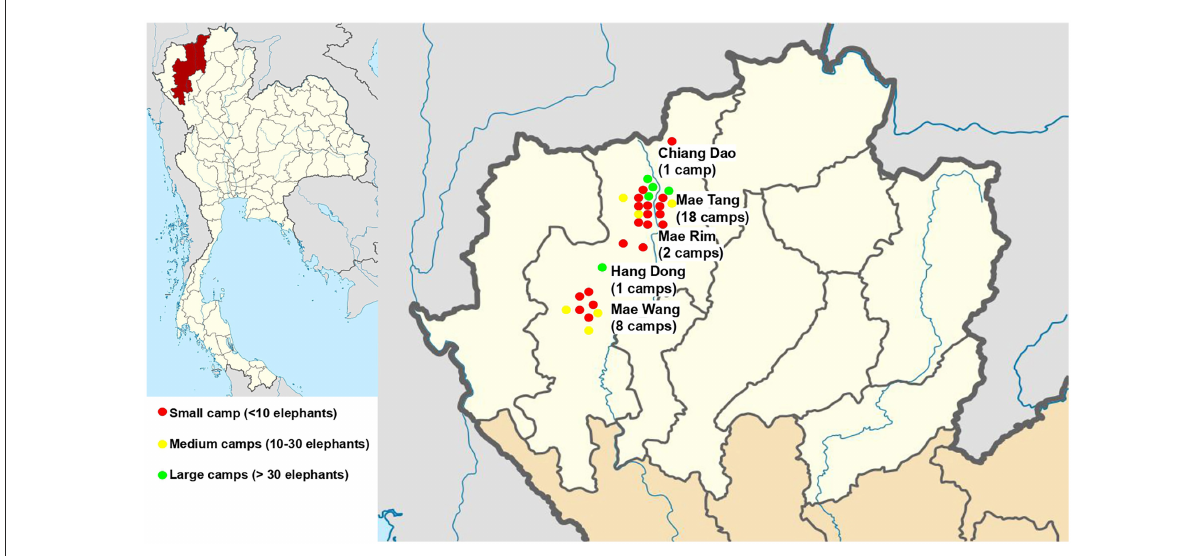
FIGURE1 Distribution of elephant camps in this study. Colored dots represent the size of elephant camps based on numbers of